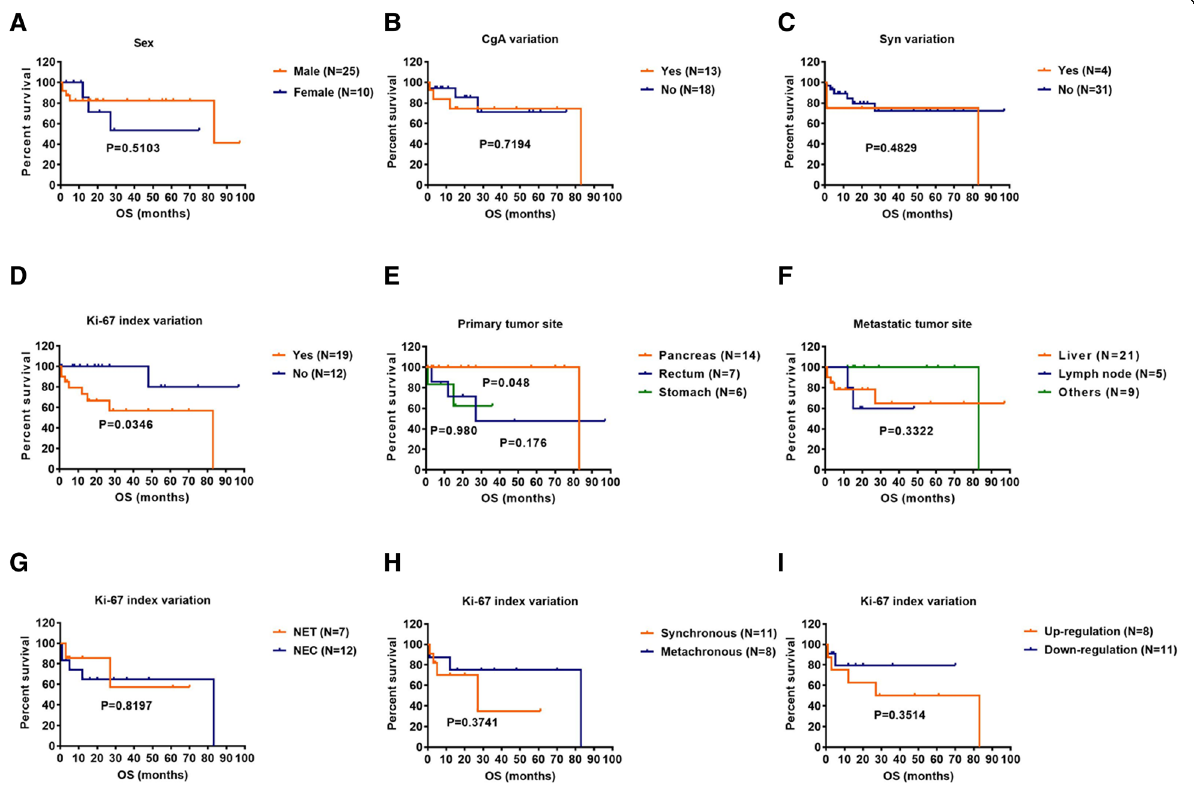
Fig. 5 Kaplan-Meier curves for overall survival in patients with multiple pathology specimens according to ( a ) Sex, ( b ) CgA variation, ( c ) Syn variation, ( d ) Ki-67 index variation, ( e ) Primary tumor site, ( f ) Metastatic tumor site. In the case of Ki-67 variation, K-M curves for overall survival in patients with multiple pathology specimens according to ( g ) Classification of NENs, ( h ) Different types of metastases, ( i ) Specific changes